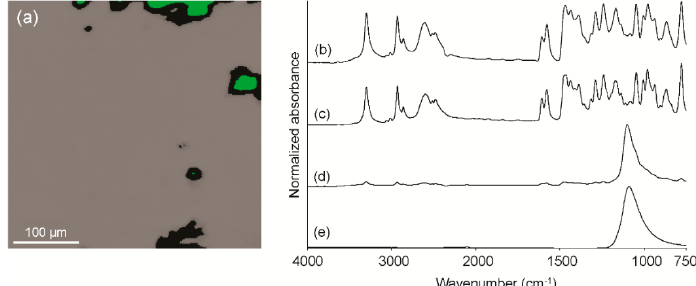
Figure 3. ATR-FT-IR image of the bulk API ( a ); representative spectrum from the gray region ( b ); pure compound reference spectrum of the API ( c ); representative spectrum from the green region ( d ); pure compound reference spectrum of sodium sulfate ( e ).